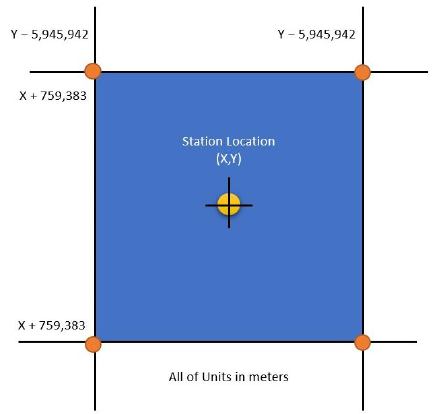
Figure 2. Coordinate Matching as illustrated in Mahmoud, M.T. et al. [10].